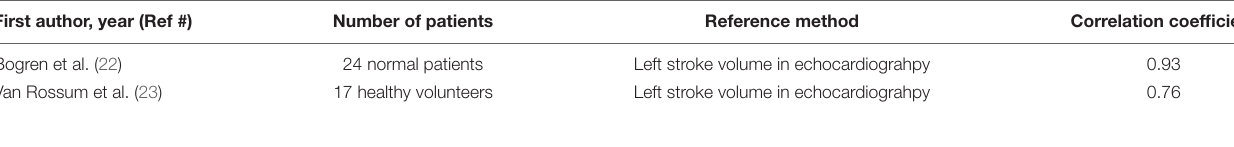
TABLE 2 | Validation of forward flow in the aorta by comparison to